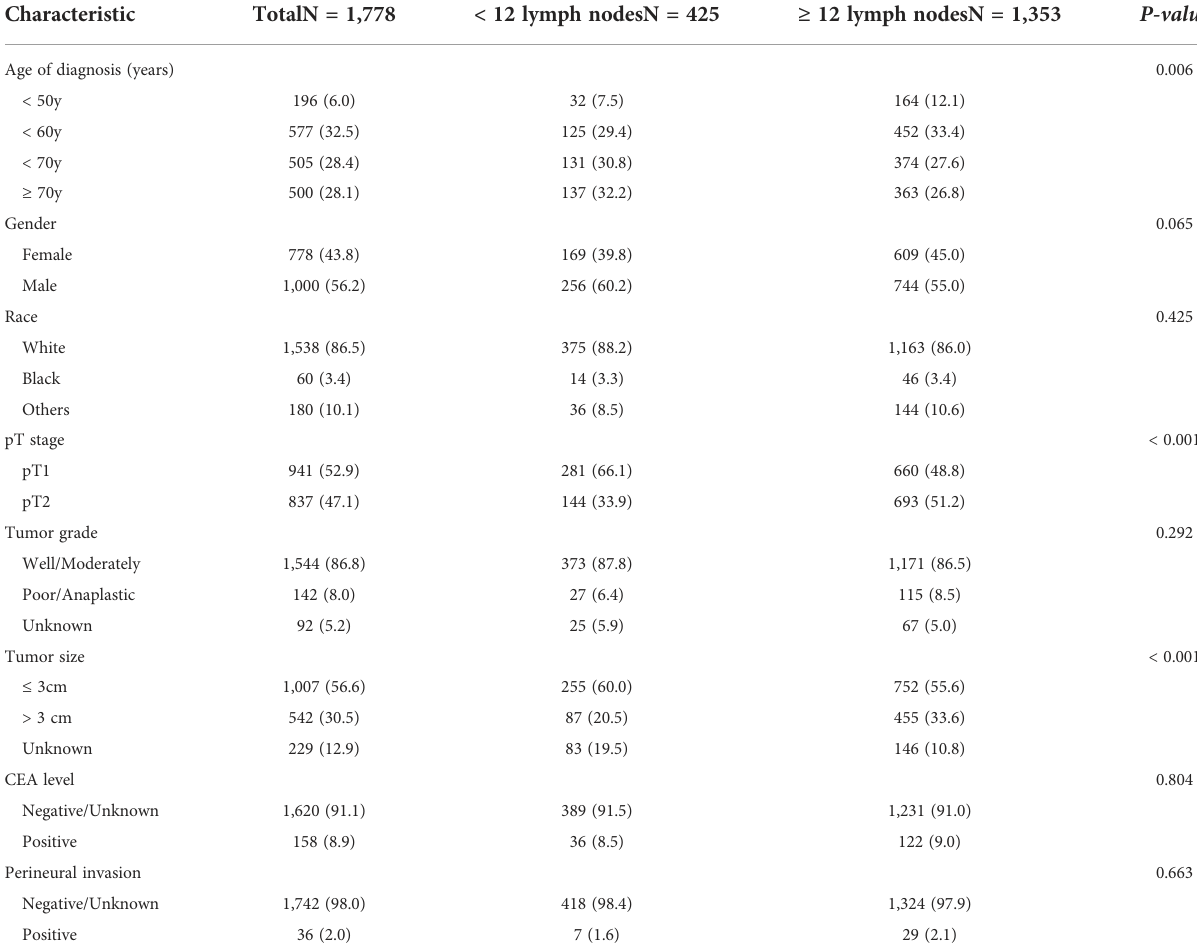
TABLE 1 Clinicopathological differences between stage I rectal adenocarcinoma patients with < 12 and ≥ 12 lymph nodes dissection.